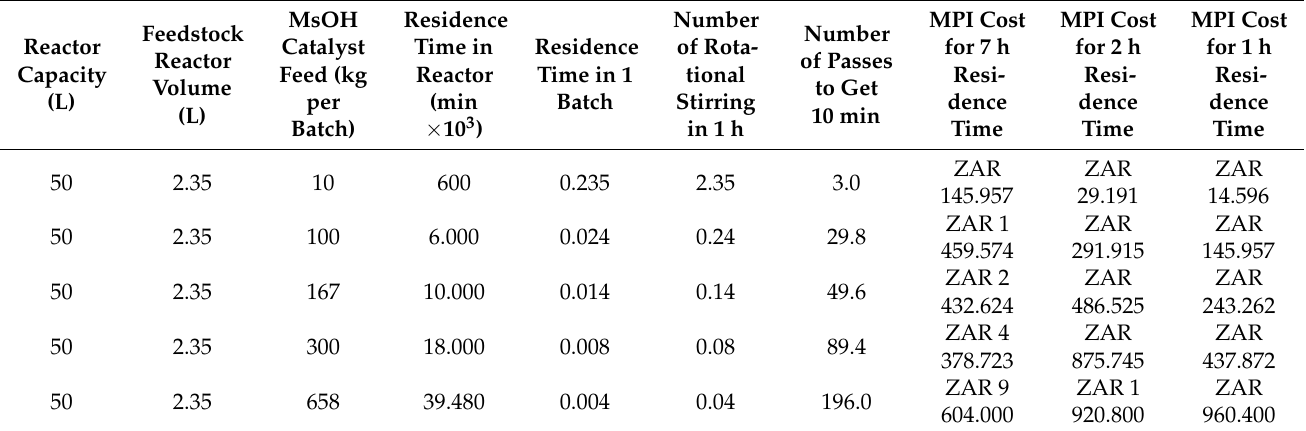
Table 6. Comprehensive capital